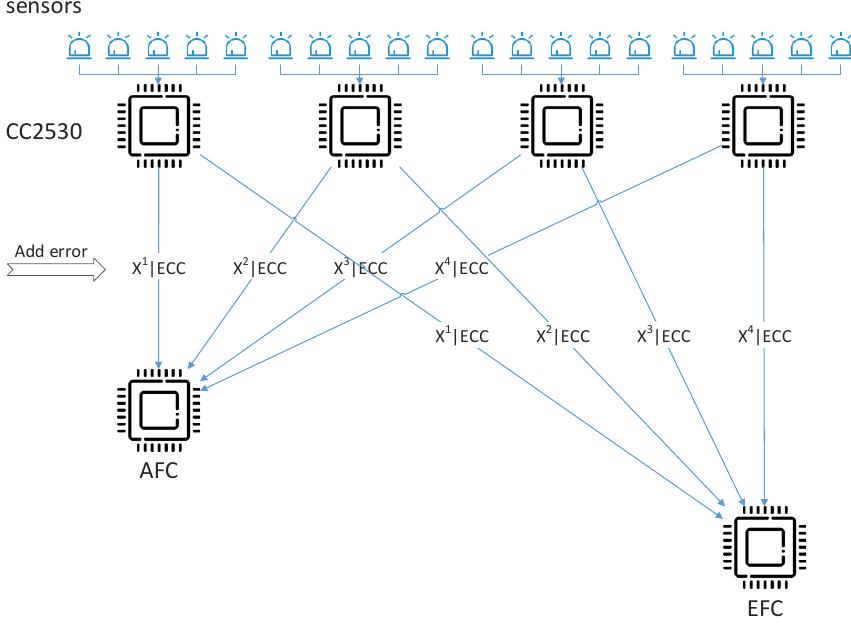
Figure 8. Experimental topology.